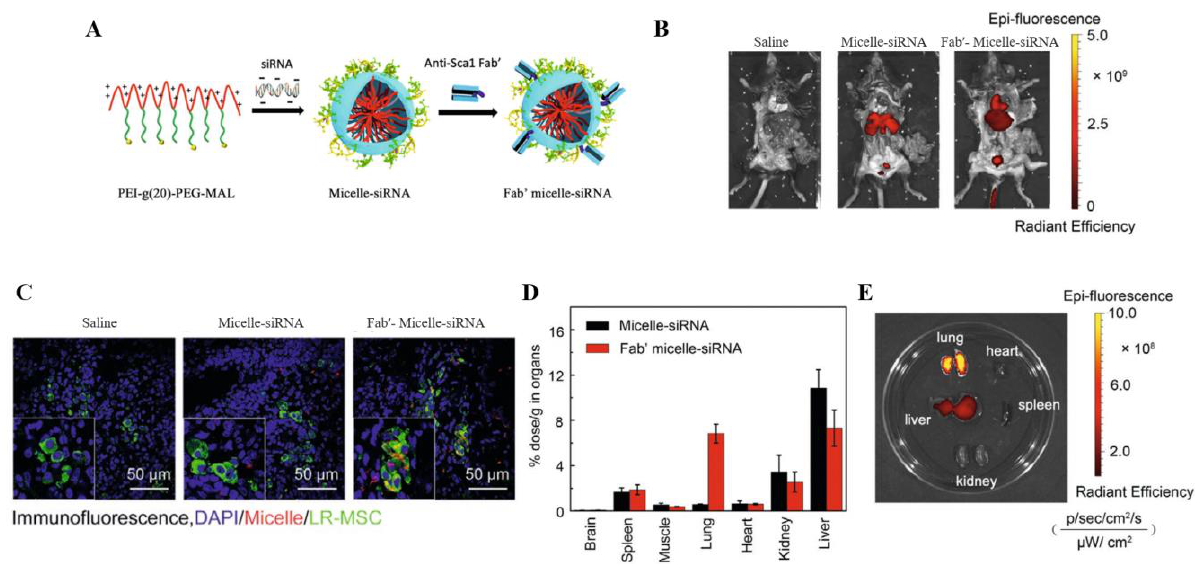
Figure 7. Targeted siRNA delivery by functionalizing the micelle surface with an anti-stem-cell antigen-1 antibody fragment (Fab ’ ) for pulmonary fibrosis therapy [62]. ( A ) Schematic diagram of the siRNA-loaded polymeric micelles targeting lung mesenchymal stem cells. ( B , C ) Biodistribution of the delivered micelles. ( D ) The biodistribution of intravenously administrated micelle – siRNA and anti- Sca1 Fab′ -conjugated Micelle-siRNA in organs and ( E ) images of the organs of a mouse administrated with Fab′– Micelle – siRNA.